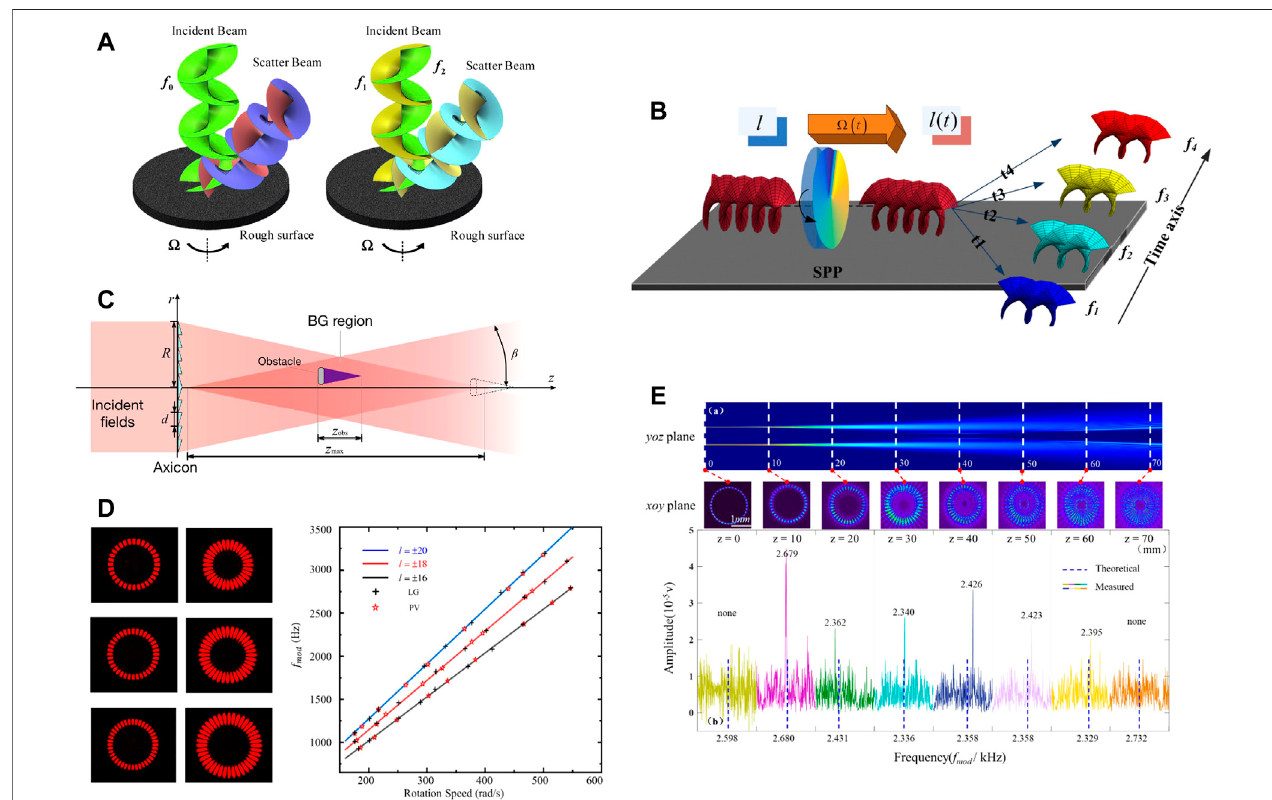
FIGURE 3 | RDE in rotational speed detection. (A) Direction-sensitive detection by dual-frequency optical vortex [48]. (B) Detection of angular acceleration based on optical RDE [51]. (C) Non-diffractive Bessel-Gaussian beams for the detection of rotational speed [57]. (D) RDE detection results by using perfect optical vortex [58]. (E) The measured results of RDE frequency shift along the propagation path of ring Airy Gaussian vortex [59].